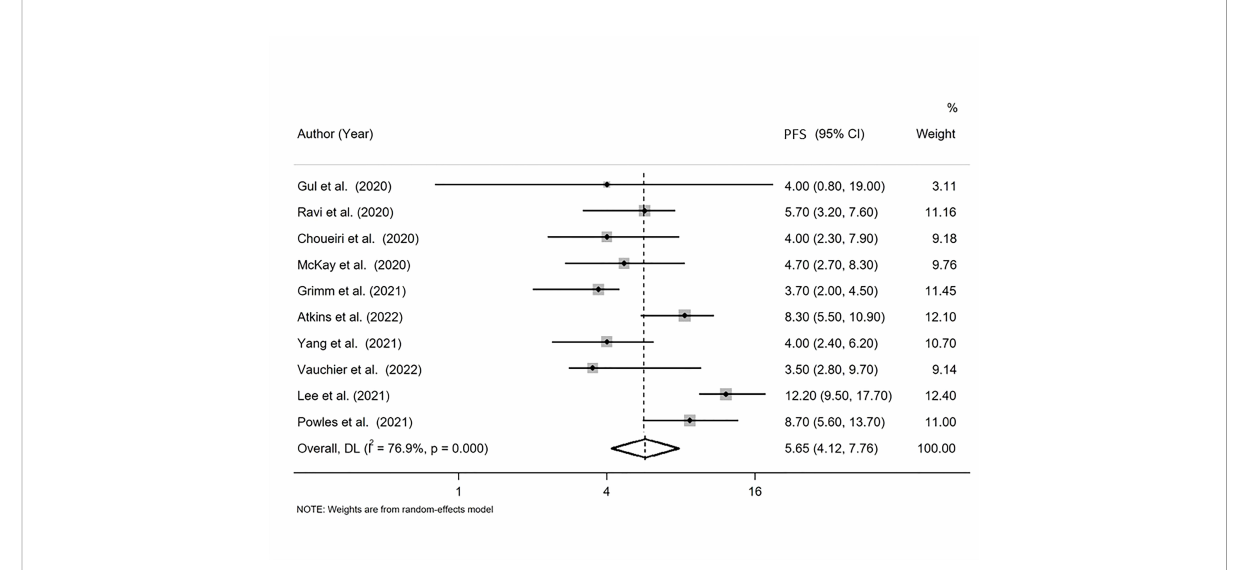
FIGURE 3 Forest plot displaying the pooled median progression-free survival (PFS) in random-effects